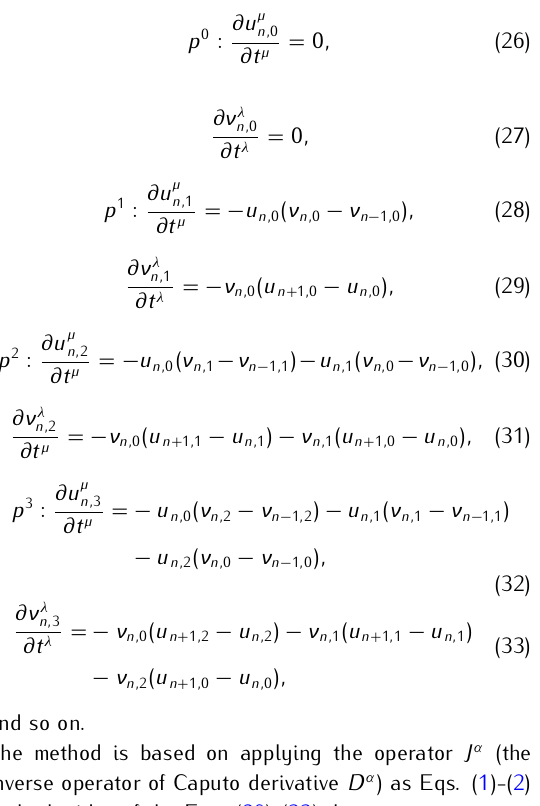
( n,t ) as in Eq. (15) (a) at µ = 1 , λ = 1 ; (b) µ = 1 , λ = 1 ; (c) µ = 1 , 2 2 3 ; (d) µ = 1 , λ = 1 with c = 0 . 1 , k = 0 , α = 0 . 01 , λ = 1 3 4 4 a [0] = 1 , β = 1 and t = 0 . 5